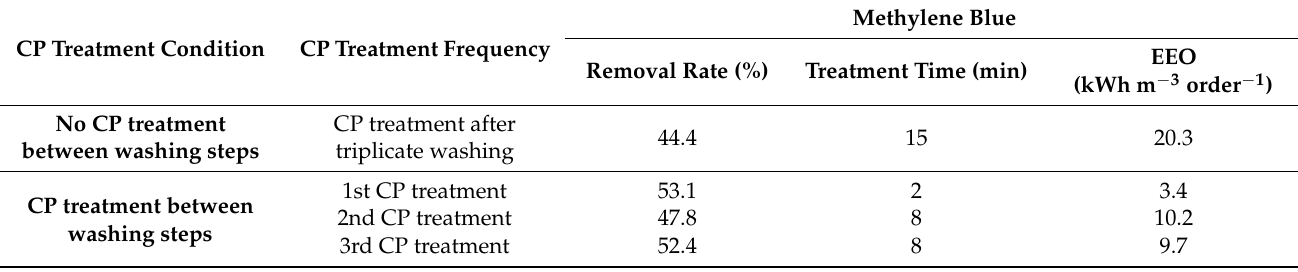
Table 3. Energy consumption of CP treatment during the removal of about half of the desorbed